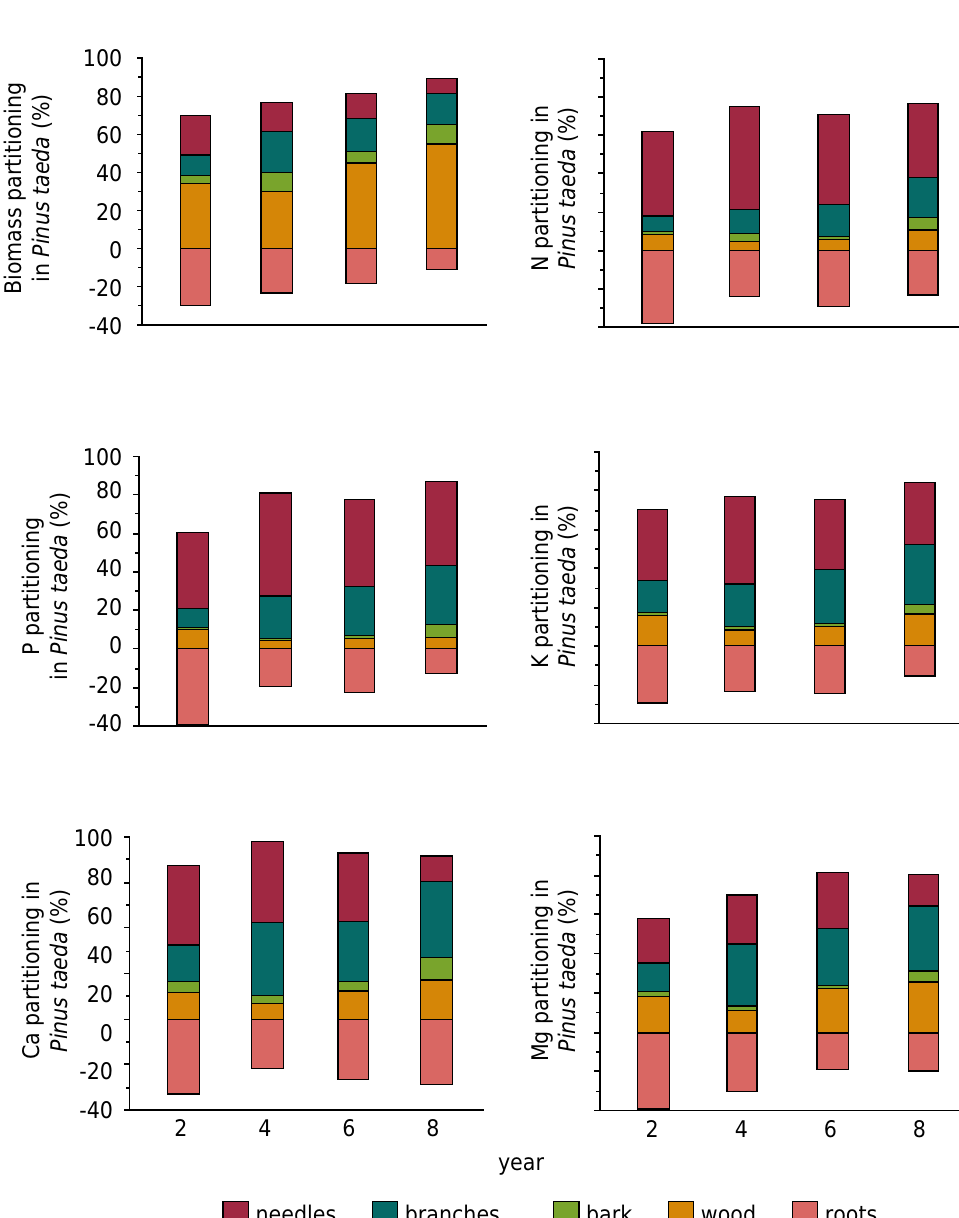
Figure 2. Biomass and nutrient partitioning in Pinus taeda trees in southern